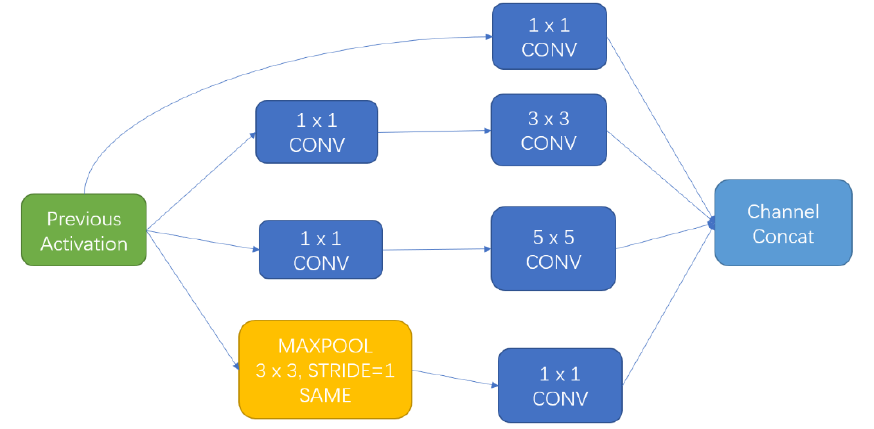
Figure 4. Inception module structure.